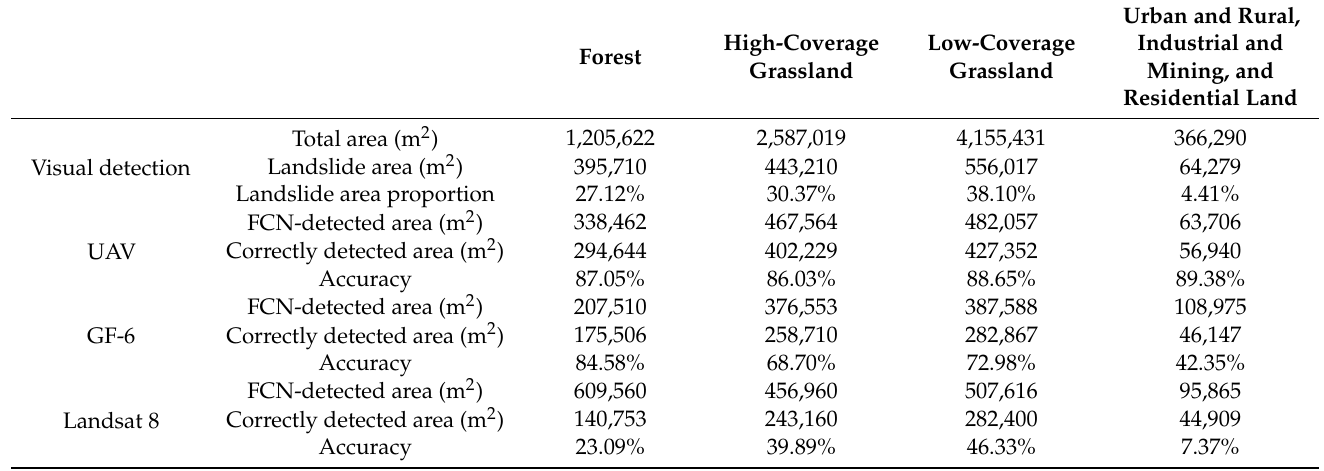
Table 6. Landslide rate under different surface coverage in remote sensing images.